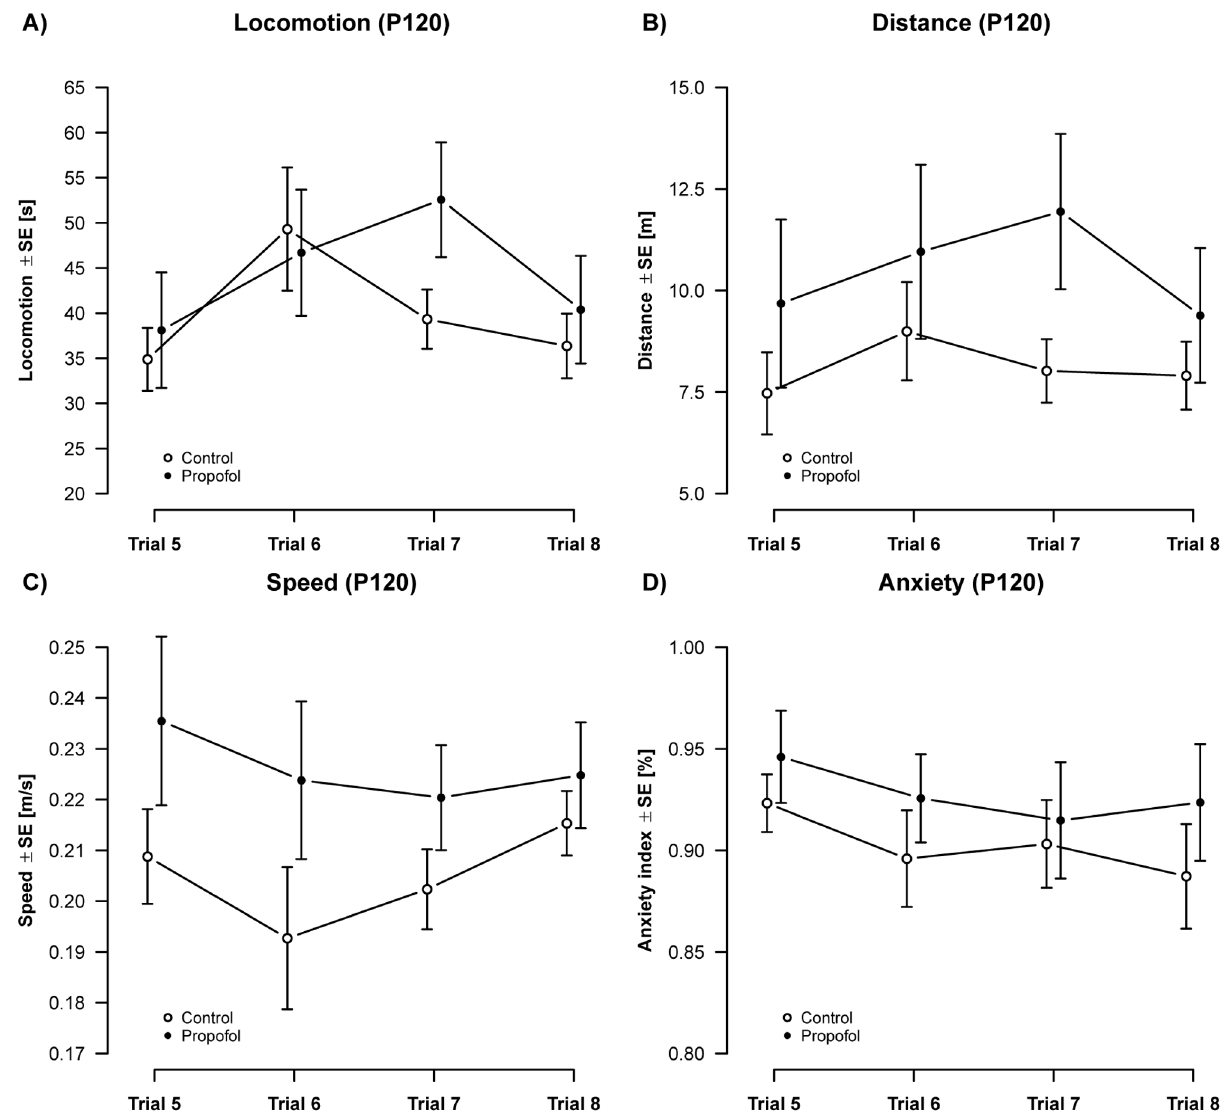
Figure 5. Activity (P120): Analysis of activity over 4 repeated measurements showed no treatment effects on A) locomotion [F(1,73)=0.94, p=0.33], B) distance [F(1,74)=1.86, p=0.18], C) speed [F(1,74)=0.44, p=0.51] or D) anxiety related behavior [F(1,62)=0.57, p=0.45] in propofol treated animals. Apart from a transient effect on locomotion [F(3,71)=5.92, p=1.13 6 10 2 3 ], no significant changes over repeated measurements were observed in adult aged animals. (n controls =12 animals, n propofol =8